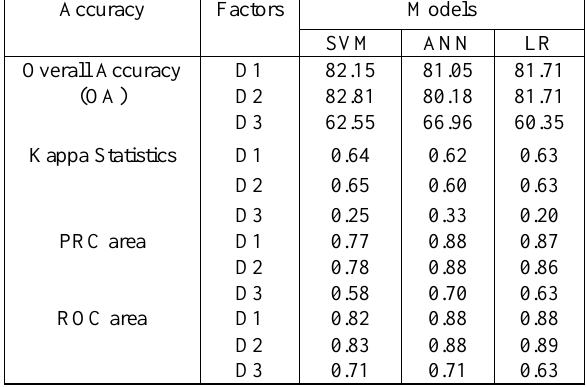
Table 3. Accuracy assessment and validation of SVM, ANN, and